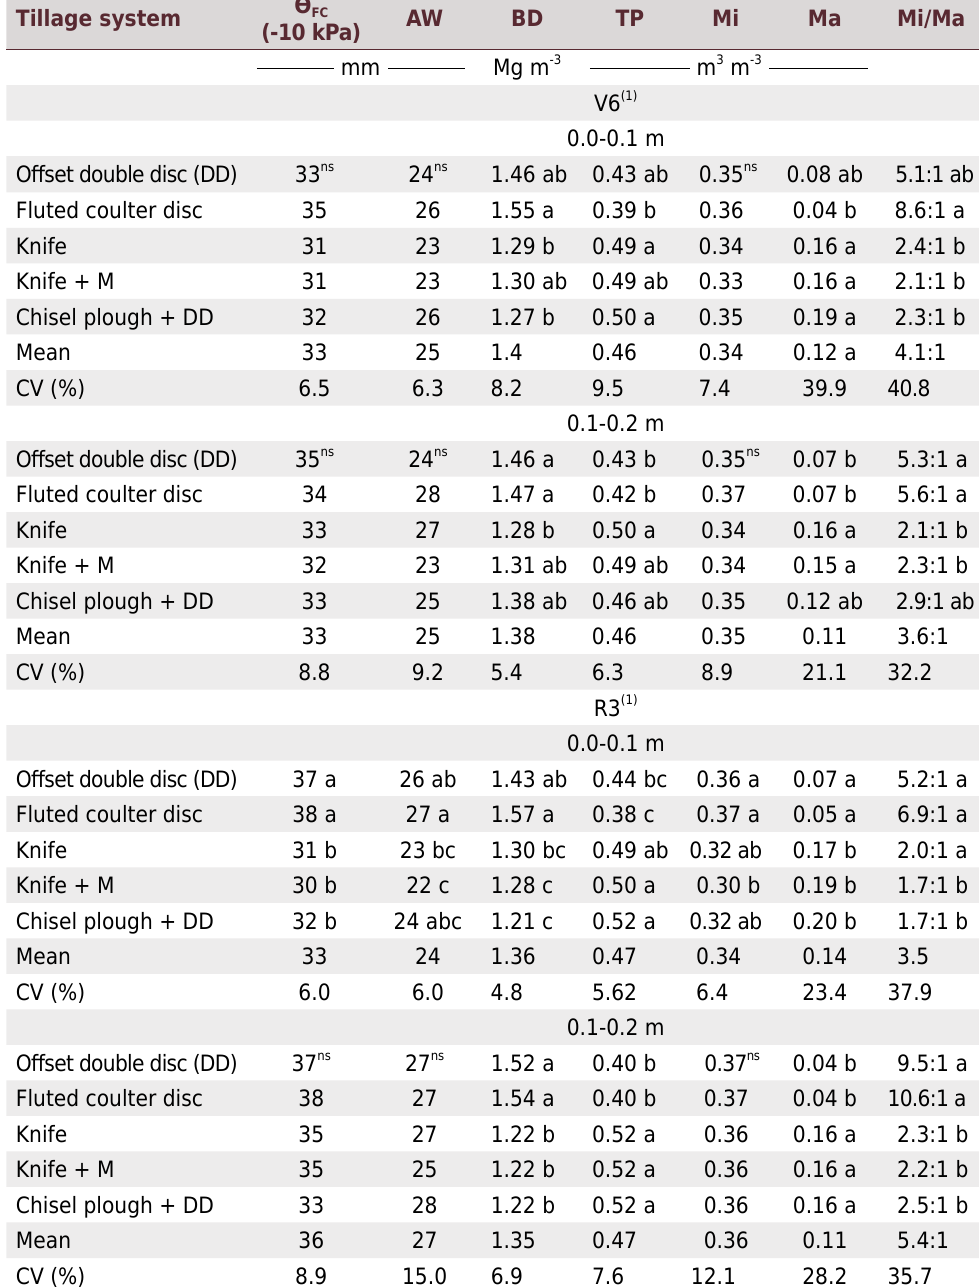
Table 5. Soil water retention at field capacity (θ FC ), available water (AW), bulk density (BD), total porosity (TP), microporosity (Mi), macroporosity (Ma), and Mi/Ma ratio in the treatments at different soil depths. Formigueiro, Brazil. Experiment 2 in the 2014/15 crop season Tillage